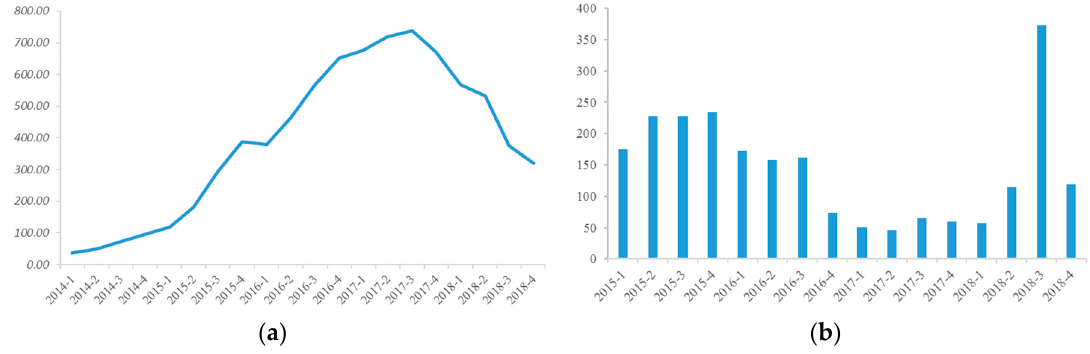
Figure 1. China’s online lending transaction volume ( a ) and number of problematic platforms ( b ).